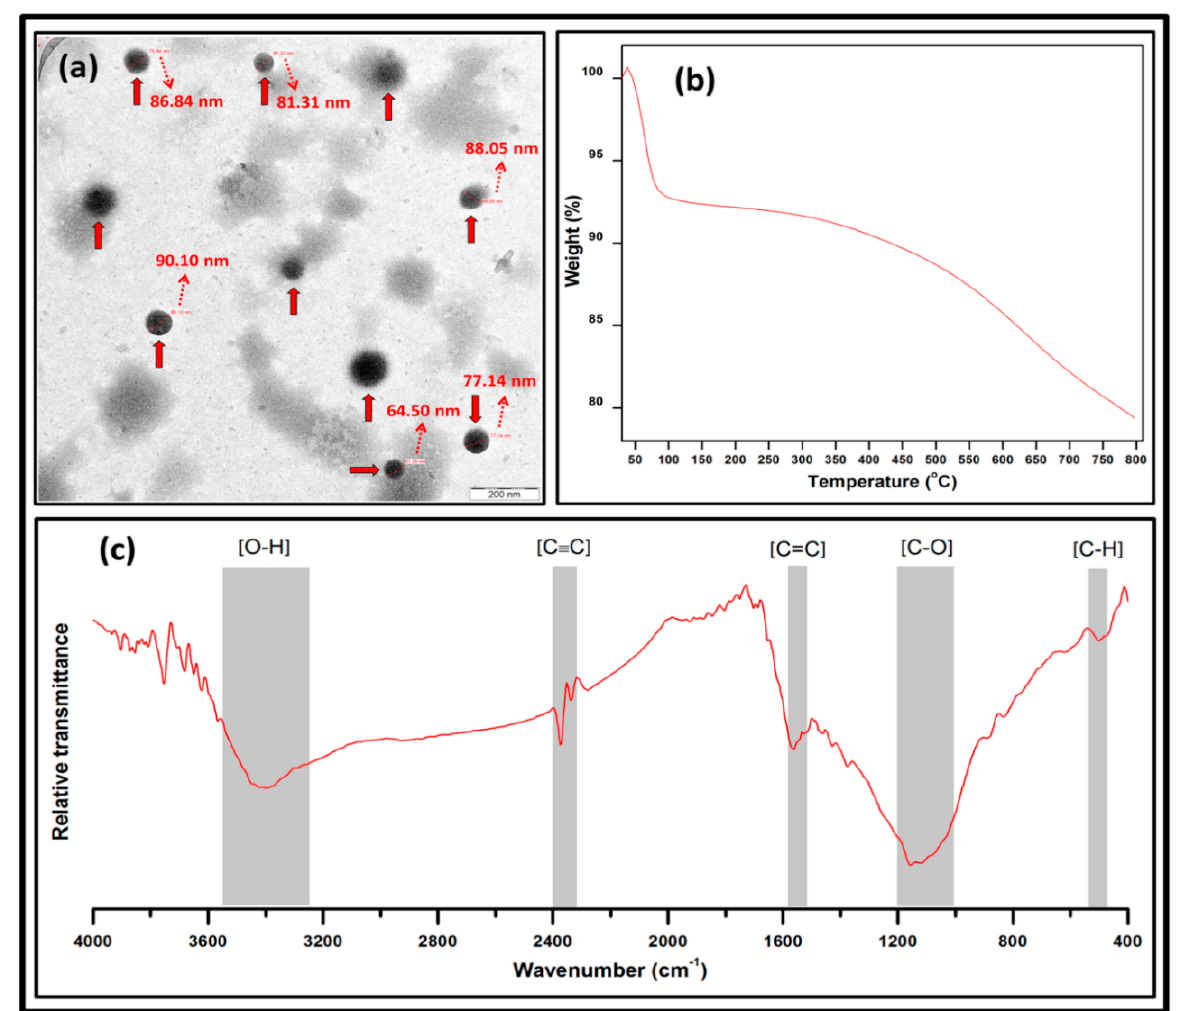
Figure 5. Characterisation of bio nanocarbon ( a ) TEM, ( b ) TGA, and ( c ) FT ‐ IR analysis.